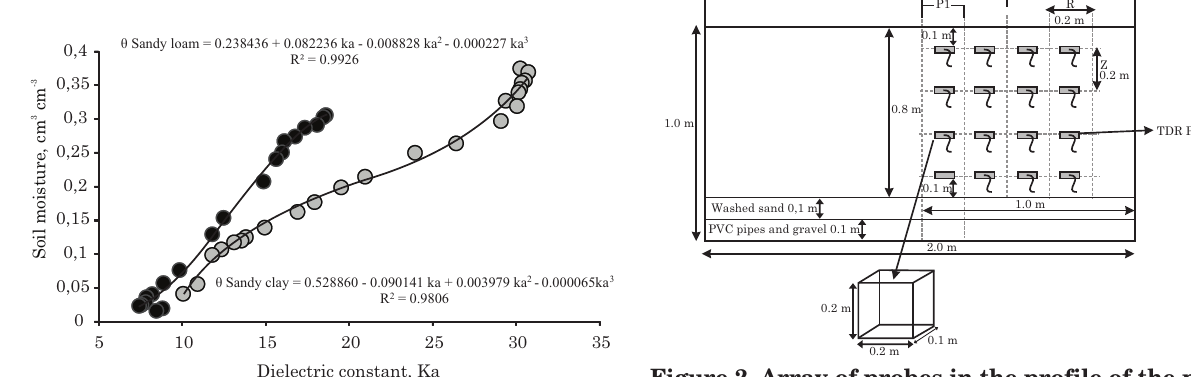
Figure 1. Relations between soil moisture ( θθθθθ ) and dielectric constant (Ka) for the two soil texture classes used in the experiment.